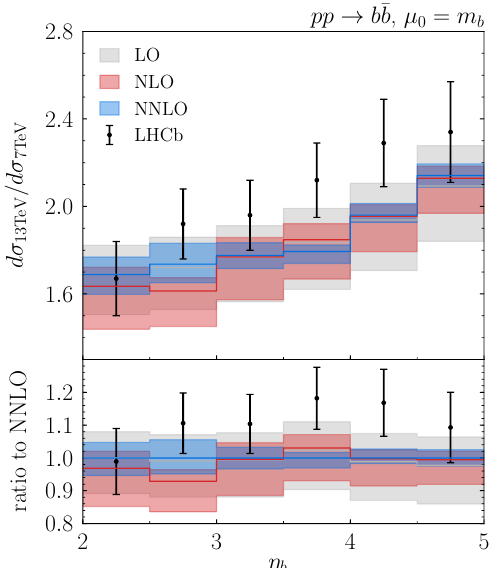
Figure 11 . Ratio of 13 TeV to 7 TeV predictions for the pseudorapidity distribution in the forward region. The lower panels show the result normalised to the NNLO prediction. The theoretical predictions are compared with the LHCb data of ref.